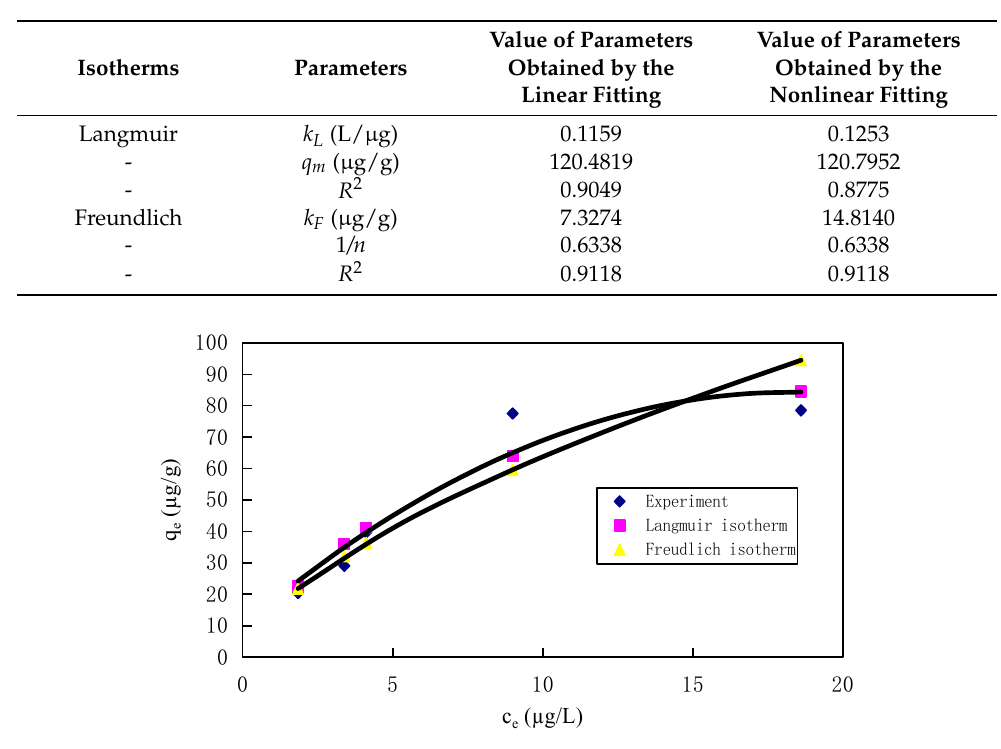
Table 2. The Langmuir and Freundlich isotherm parameters for the removal of the Hg ions by the Fe 3 O 4 /rGO composites.